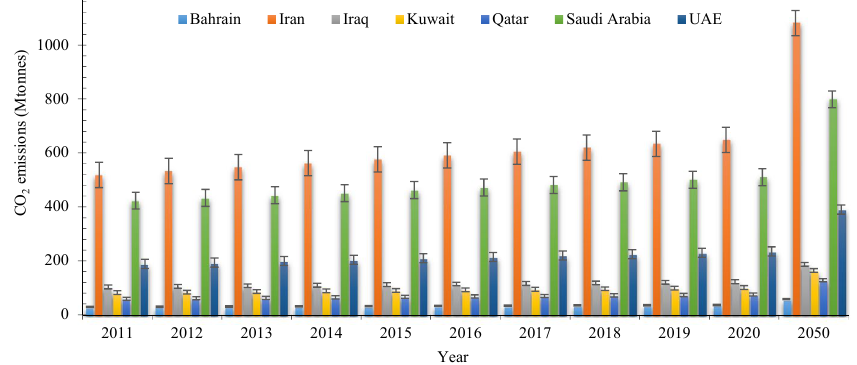
Fig. 4: Projected levels of CO